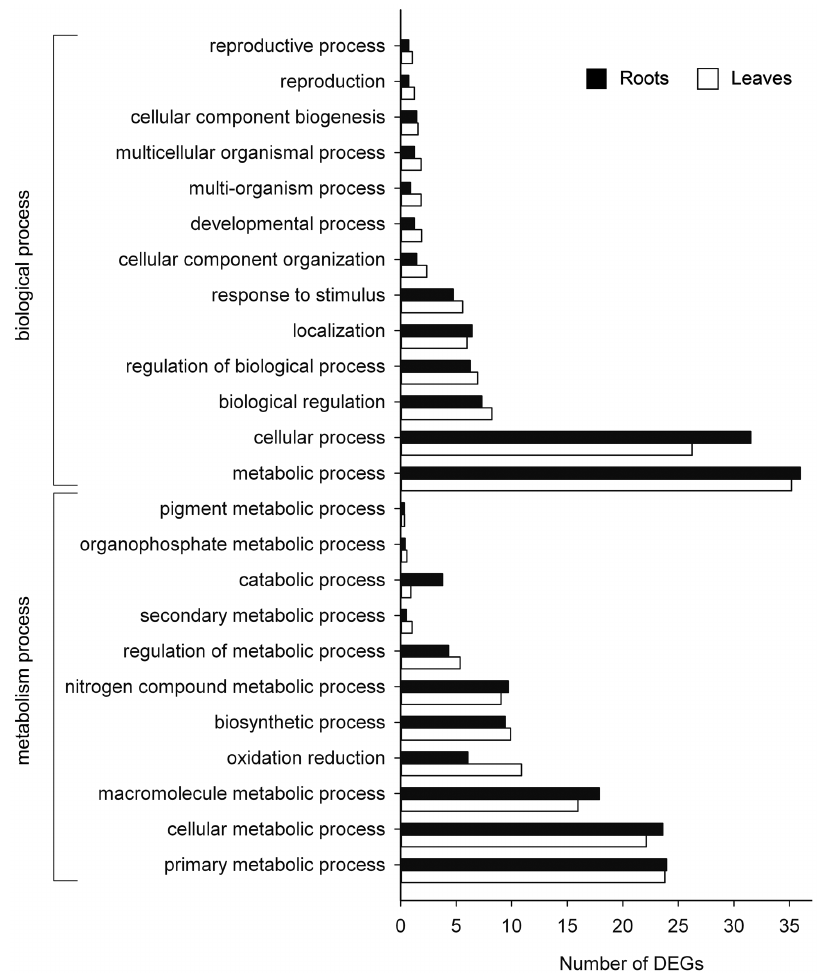
Figure 2. GO process analysis of the DEGs in the tested tissues.